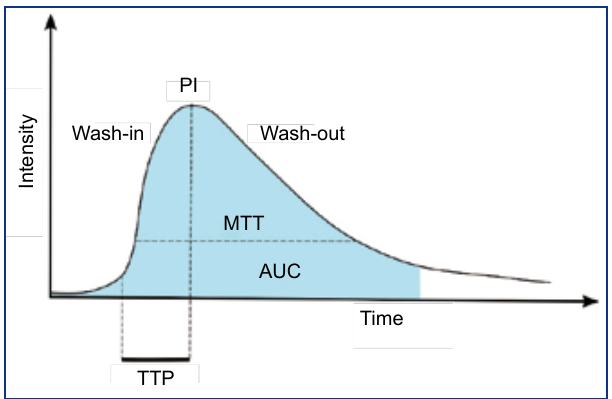
Figure 2 Graph showing different parameters obtained from the time- intensity curve (TIC) of CEUS imaging. PI, peak intensity; AUC, area under the curve; MTT, mean transit time; TTP, time to